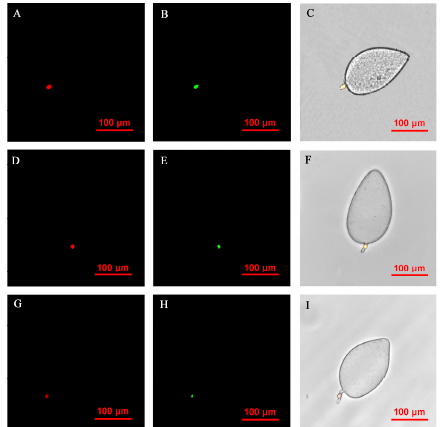
Figure 3. FISH visualization of Wolbachia and Ricke tt sia in egg stages (3–9 h) of B. tabaci. Localization of symbiotic bacteria Ricke tt sia (red) and Wolbachia (green) in the B. tabaci eggs at di ff erent times (( A – C ): 3 h, ( D – F ): 6 h, ( G – I ): 9 h). Ricke tt sia fl uorescence ( A , D , G ) and Wolbachia fl uorescence ( B , E , H ) are displayed in dark fi eld; W olbachia and Ricke tt sia fl uorescence ( C , F , I ) is displayed in bright fi eld.